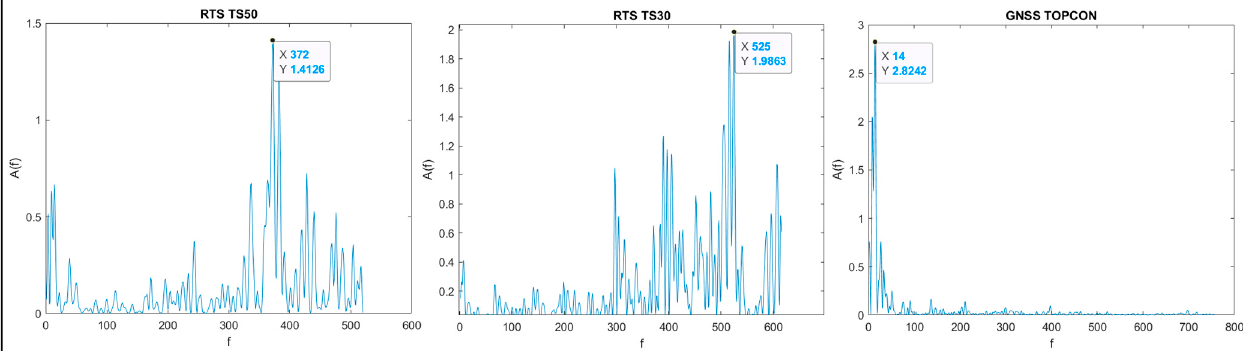
Figure 6. The entire frequency spectrum of the Lomb–Scargle periodogram. Table 2. Measured values obtained by geodetic methods. Geodetic Measurement Equipment